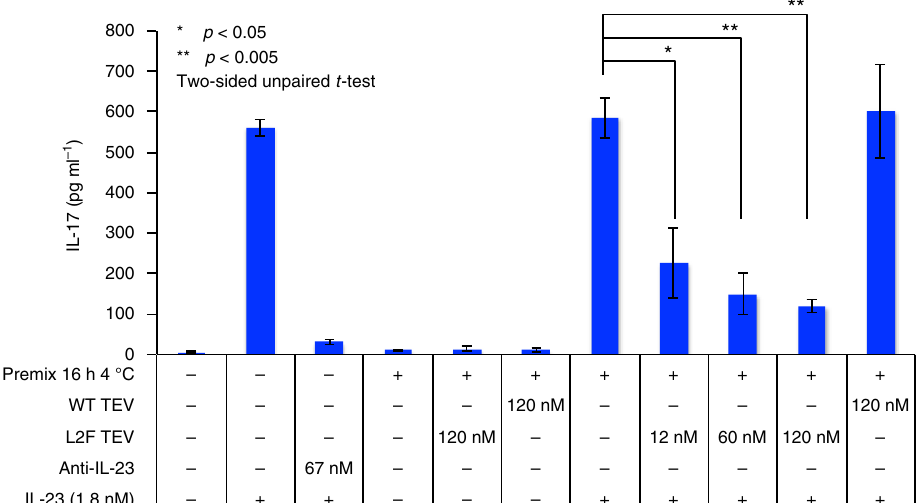
Fig. 4 Protease-mediated attenuation of IL-17 secretion in mouse splenocytes. The activity of IL-23 in vivo is mediated by stabilization of a T-helper cell lineage (Th 17 ) that secretes IL-17, leading to downstream pro-in fl ammatory signals. This pathway can be assayed within a culture of mouse mononuclear splenocytes, by measuring the amount of IL-17 secretion into the cell culture media using an ELISA. As a positive control, anti-IL-23 antibodies in a super- stoichiometric ratio prevent IL-17 secretion. Preincubation of IL-23 and evolved TEV L2F attenuates IL-17 secretion, demonstrating that cleavage of the HPLVGHM target site inactivates immune signaling capabilities of IL-23. Values represent the mean and error bars represent the standard deviation